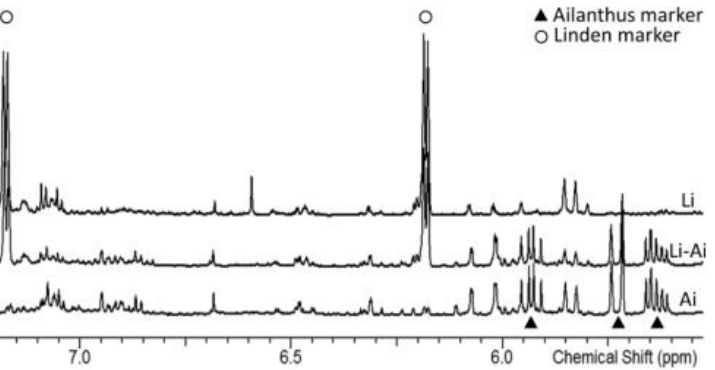
Figure 6. A region of the 1 H NMR spectra of chloroform extracts where the linden and ailanthus markers resonate: (from top to bottom) monofloral linden honey; honey containing both linden and ailanthus; monofloral ailanthus honey (Reprinted with permission from [35]. Copyright 2016 American Chemical Society).